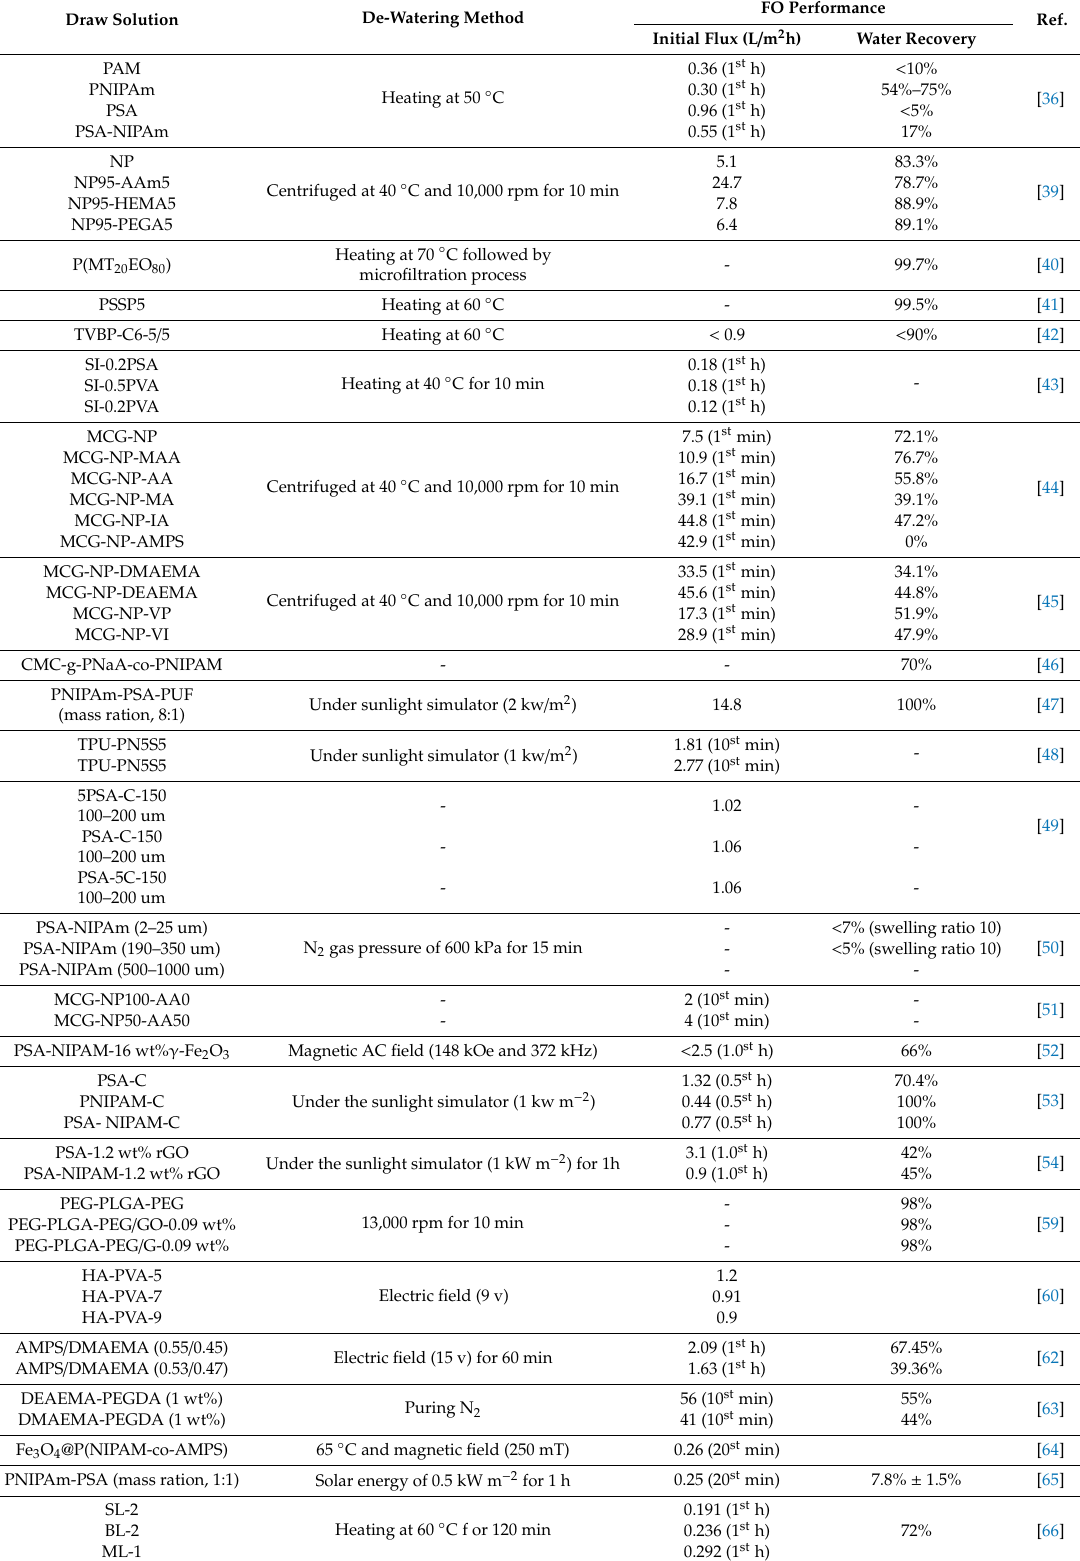
Table 1. Summary of various types of hydrogels as draw solutes in the forward osmosis (FO)